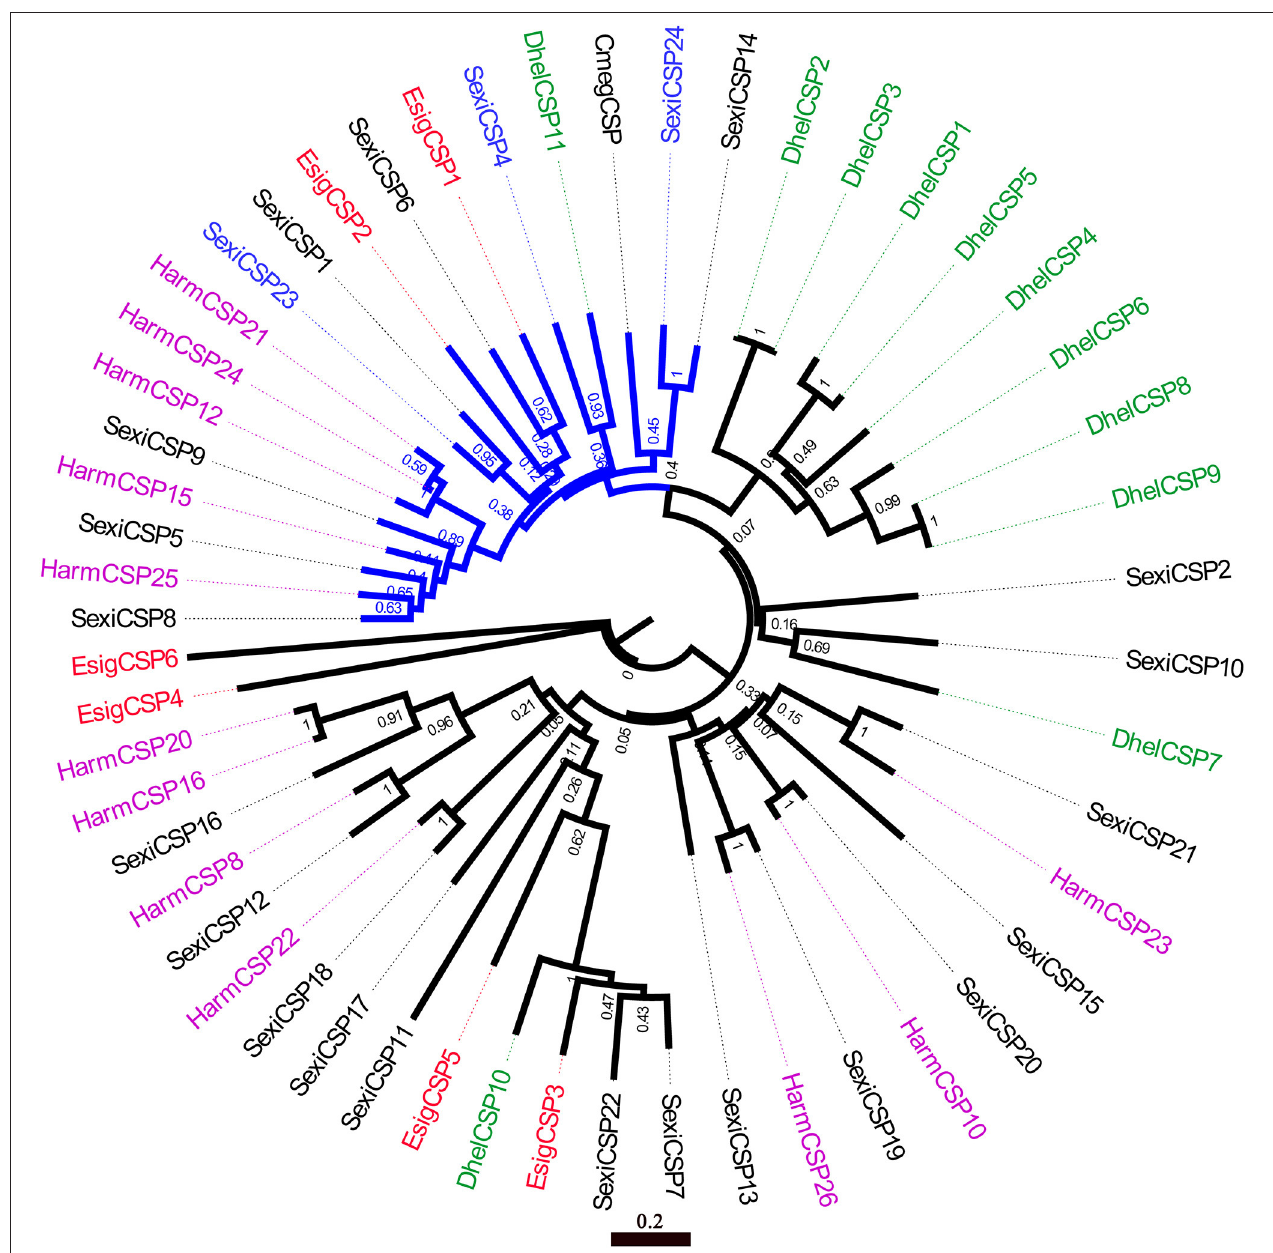
FIGURE 6 | Neighbor-joining phylogenetic tree of chemosensory proteins (CSPs). The NJ phylogenetic analysis of CSPs of E. signifier (EsigCSP, red) was performed with reference CSPs of D. helophoroides (green), C. megacephala (black), S. exigua (black), H. armigera (purple) and E. signifier . Blue CSPs of P. xylostella showed no larval expression. The stability of the nodes was assessed by bootstrap analysis with 1,000 replications, and only bootstrap values ≥ 0.6 are shown at the corresponding nodes. The scale bar represents 0.2 substitutions per